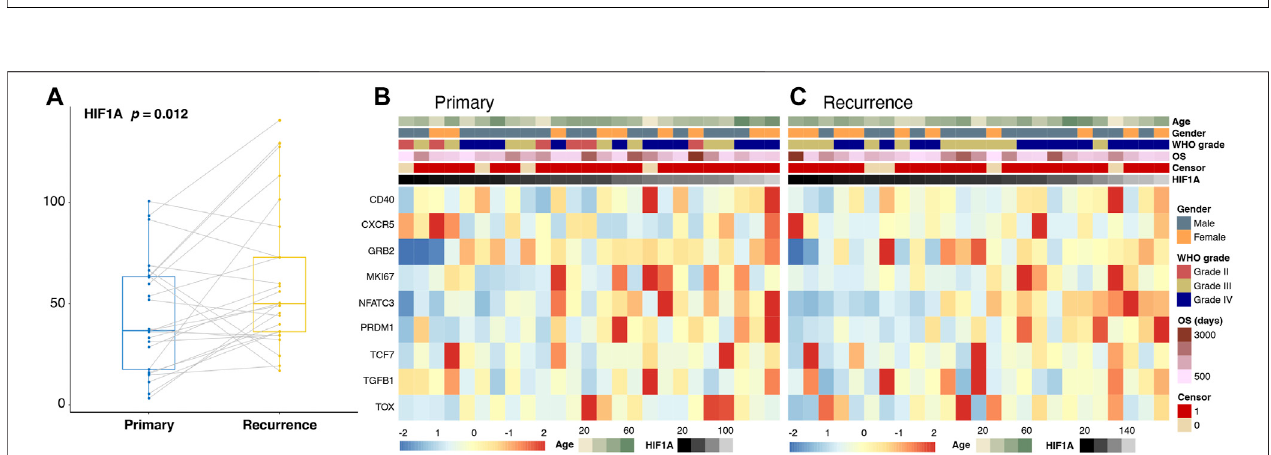
FIGURE 3 | Changes in the expression levels of HIF1A (A) and T-cell exhaustion-related genes (B,C) in paired primary and recurrence gliomas.